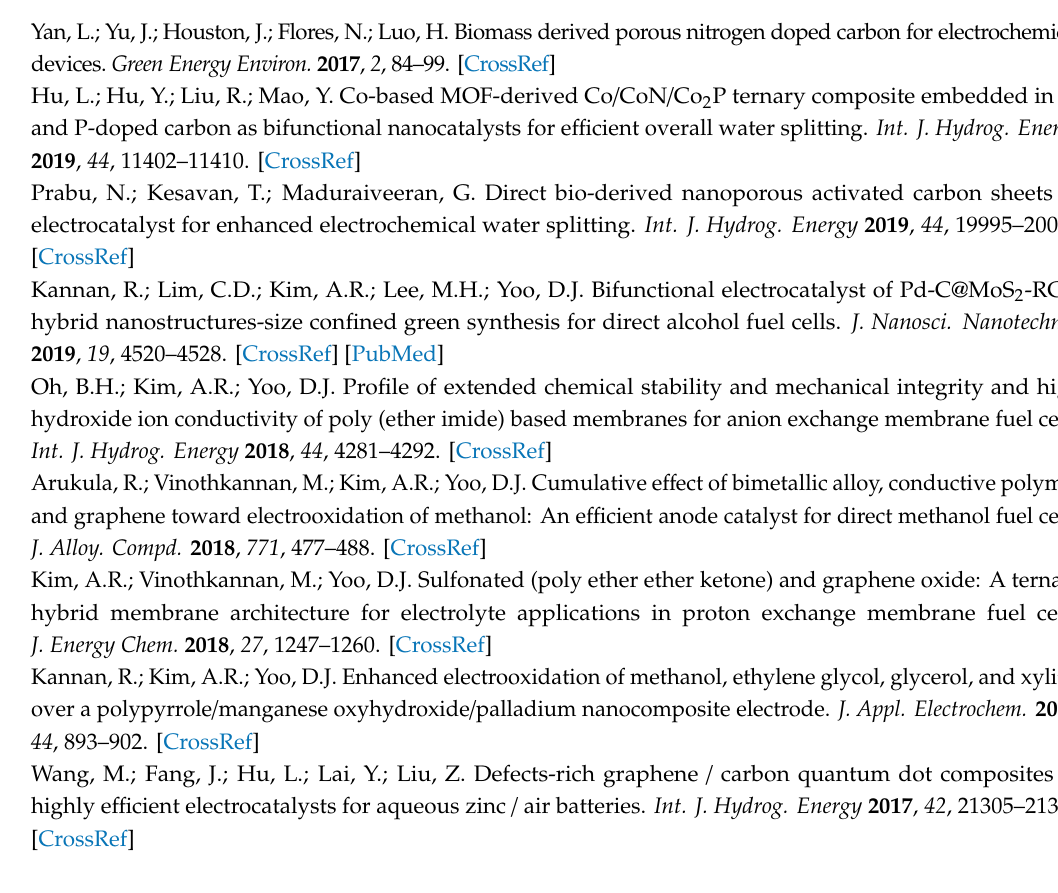
Figure S1: (a-d) SEM image elemental mapping of C, N, and O for N-PC; Figure S2:Raman spectrum of PC with a deconvolution of the D / G spectral region; Figure S3: Deconvoluted XPS spectra of PC (a) C1s (b) O1s; Figure S4: (a) CV curves of PC and Pt-C in O 2 saturated (b) E ff ect of the catalyst loading on the number of electrons transferred; Figure S5: Long term durability of N-PC and Pt-C in 0.1 M KOH; Figure S6: CV curves of (a) PC and (b) N-PC with di ff erent scan rate from 5–25 mV S –1 ; (c) linear fit of ∆ J / 2 Vs scan rate, Table S1: Comparison of ORR performance for N-PC with other Bio-derived activated carbon; Table S2: Comparison of OER performance for N-PC@Ni with other N-doped carbon materials; Table S3: Comparison of HER performance for N-PC@Ni with other N-doped carbon